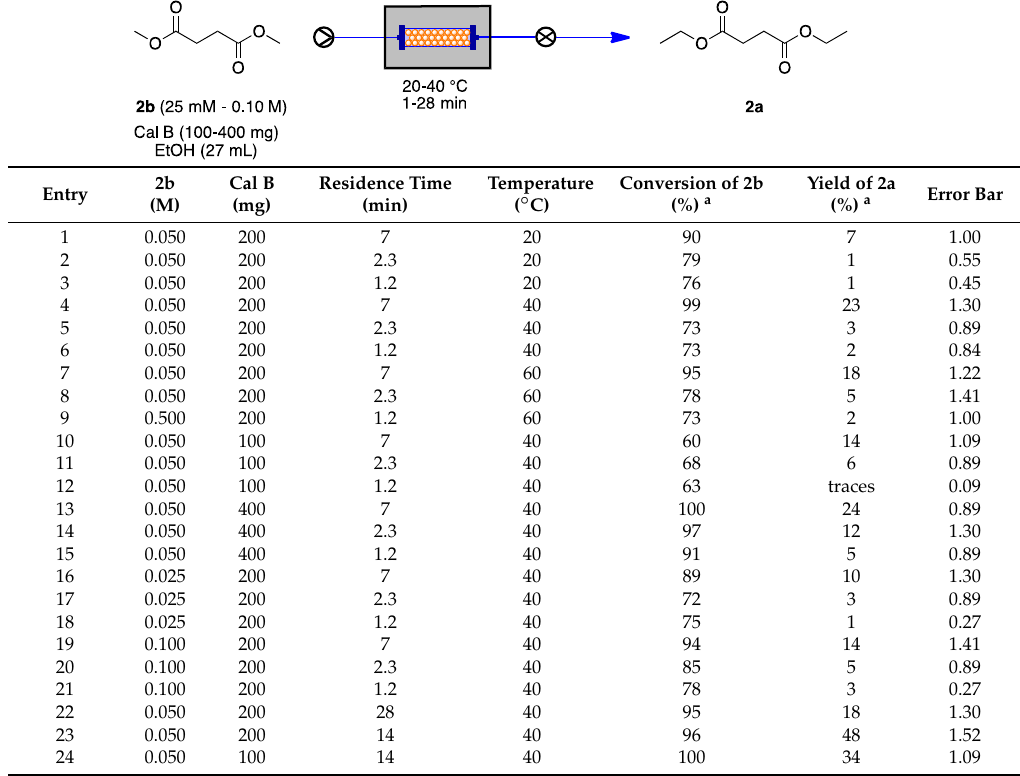
Table 6. Flow chemoenzymatic synthesis of diethyl succinate ( 2a ) by varying the concentration, temperature, and residence time.